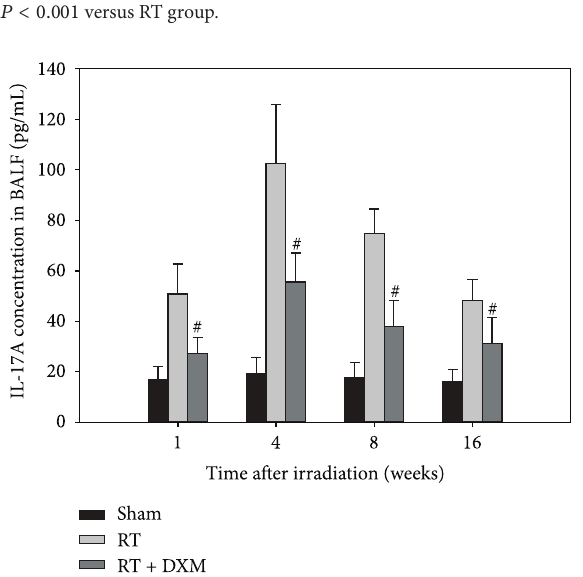
Figure 2: Expression of IL-17A in BALF at the indicated time points. The mice were sacrificed at the time of 1, 4, 8, and 16 weeks after irradiation, and BALF was collected for analysis of IL-17A contents. The contents of IL-17A in the BALF were analyzed by ELISA kits. Radiation stimulated an increase in the levels of IL-17A, but dexamethasone attenuated the IL-17A level in BALF. # 𝑃 < 0.05 versus RT group at corresponding time points. Data are presented as the mean ± SD ( 𝑛 = 8